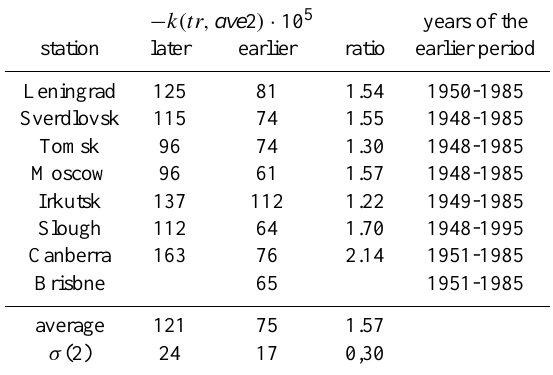
Table 5. The trends derived for the earlier and later periods − k(tr, ave 2 ) · 10